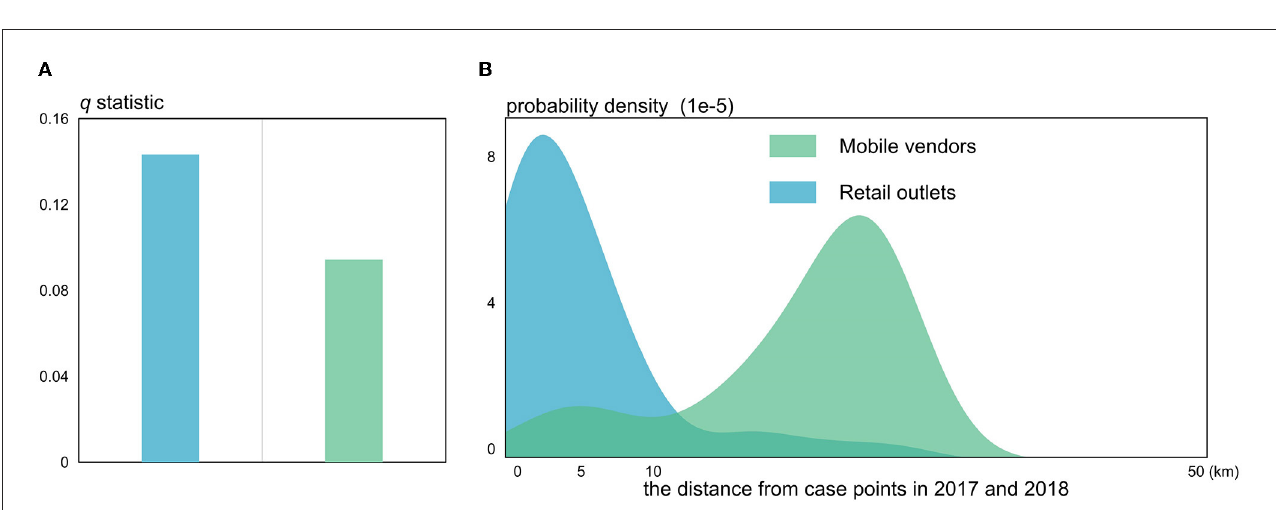
FIGURE9 The q -statistic (A) and probability density distributions (B) for the foodborne